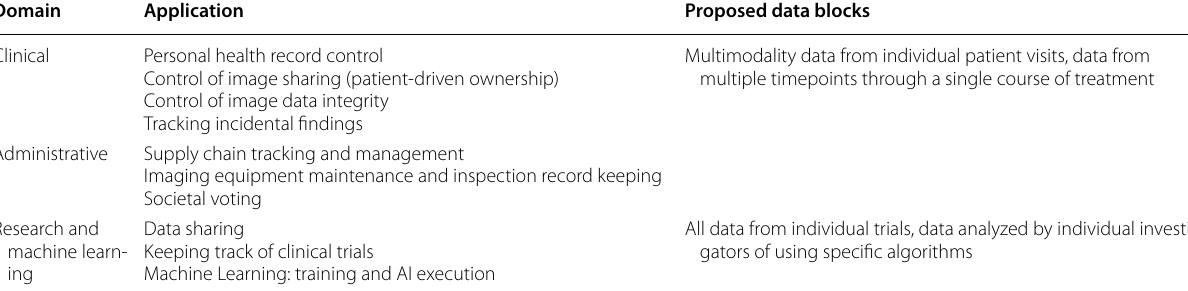
Table 2 Potential use cases of blockchain in radiology